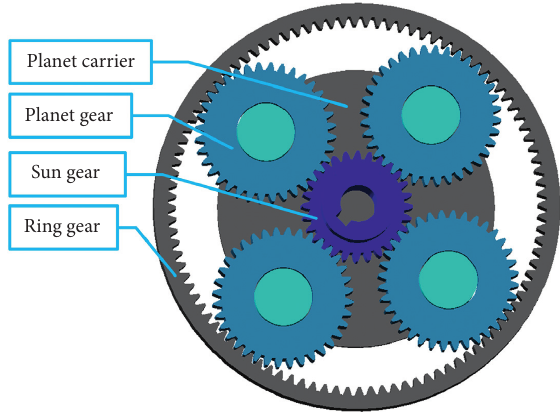
Figure 2: 3D model of planetary gear